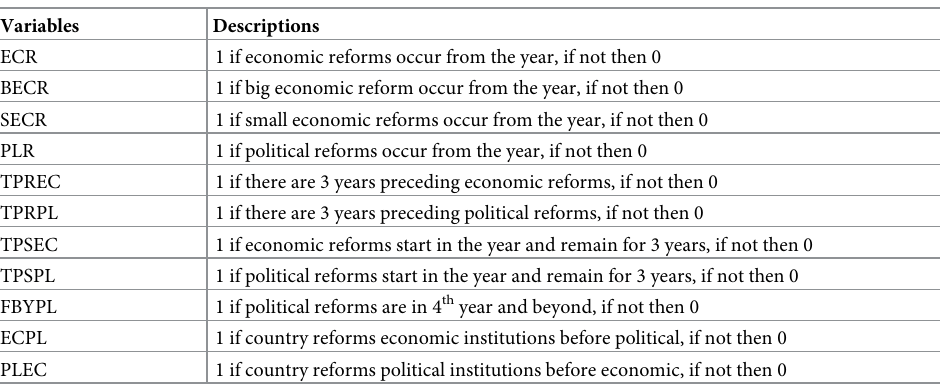
Table 1. Variables and their